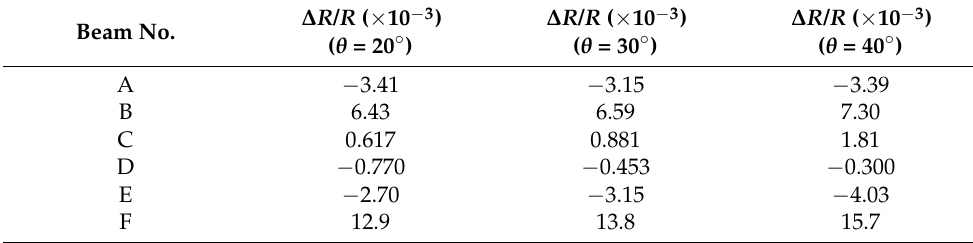
Figure 18. Sensor outputs toward shear stresses applied in 20, 30, and 40 degrees. ( a ) response of the sensor when it was tilted for 20 degree, ( b ) response of the sensor when it was tilted for 30 degree, ( c ) response of the sensor when it was tilted for 40 degree. Table 6. Angle experiment results for ψ = 5 kPa.